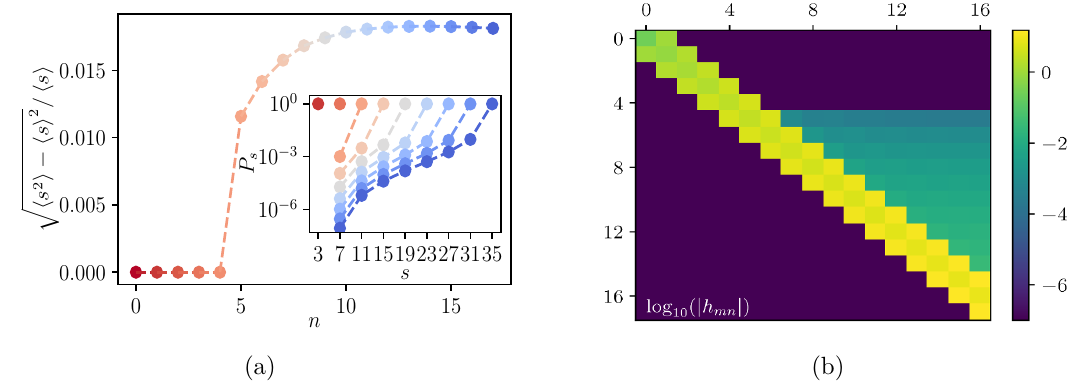
Figure 1 . (a) Operator size distribution of the Krylov basis operators O n in large N , q = 4 SYK model. In the main plot, we plot the standard deviation of the operator size divided by the average size of O n as a function of n . The inset shows the whole operator size distribution for a few Krylov basis operators (the value of n is given by the color code which is the same as in the main). The dashed lines are a guide to the eye. The distribution is strongly peaked at the largest operator size s = ( q − 2) n + 1 present in O n , so that the standard deviation is ≤ 0 . 016 times the mean for all n ≤ 17 , and appears to tend to a constant as n increases. (b) Magnitude of the matrix elements of the matrix h m,n resulting from the Arnoldi iteration in the large N , q = 4 dissipative SYK model with ˜ µ = 1 and J = 1 . The presence of the secondary off-diagonal elements in the upper Hessenberg form indicates the finite q